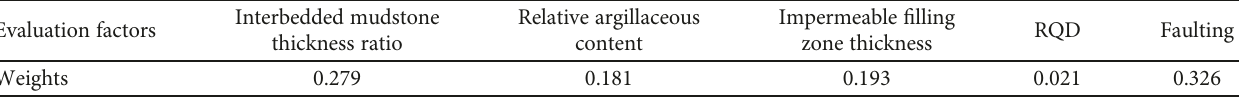
Figure 7: Flow chart of the WFCM algorithm. Table 2: The weight of condition factors obtained from the entropy